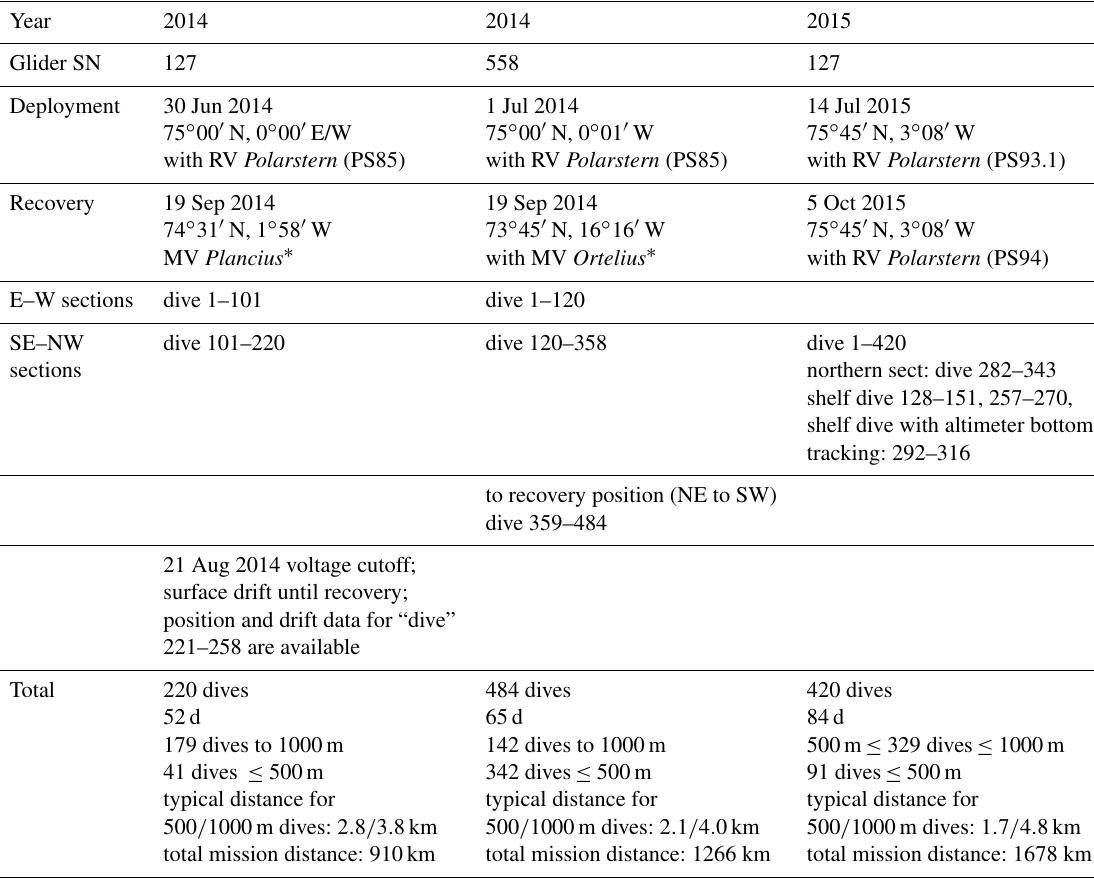
Figure 2. Maps of the Seaglider missions in 2014 (a) and 2015 (b) . (a) For 2014 the thick red line shows the track of Seaglider 127 and the thick green line the track of Seaglider 558. (b) For 2015 the thick blue line shows the track of Seaglider 127. The thin black lines give water depth contours of 300, 1000 and 3000m as annotated in Fig. 1 and the thin gray lines depth contours of 200, 500 and 2000m (not annotated) based on RTOPO2 (Schaffer et al., 2016). The color-coding denotes the concentration of sea ice in percent as derived from the sea ice data made available by Drift+Noise (https://driftnoise.com/, last access: 4 June 2019); (a) 14 August 2014; (b) 1 August 2015. Details of the missions are summarized in Table 1. The development of the ice coverage during the missions’ time is described in detail in Sect. 2.4. The location of the map is shown as an insert in Fig. 1 with a blue line. Table 1. General information on the two glider missions in summer 2014 and summer 2015. SN denotes serial